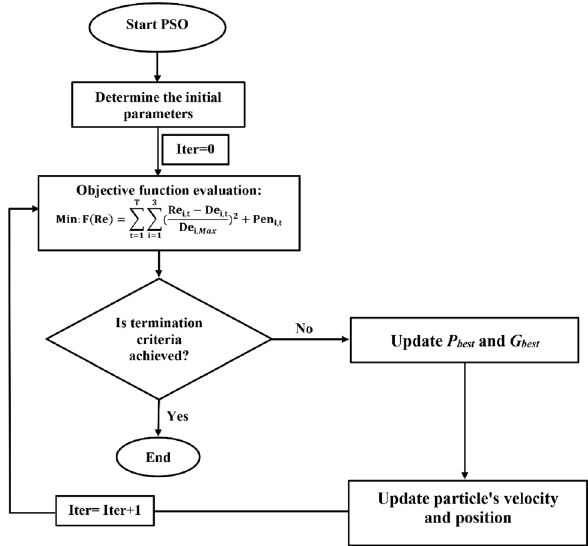
Figure 6. Flowchart of PSO algorithm in the optimal operation of Halilrood multi-reservoirs system.